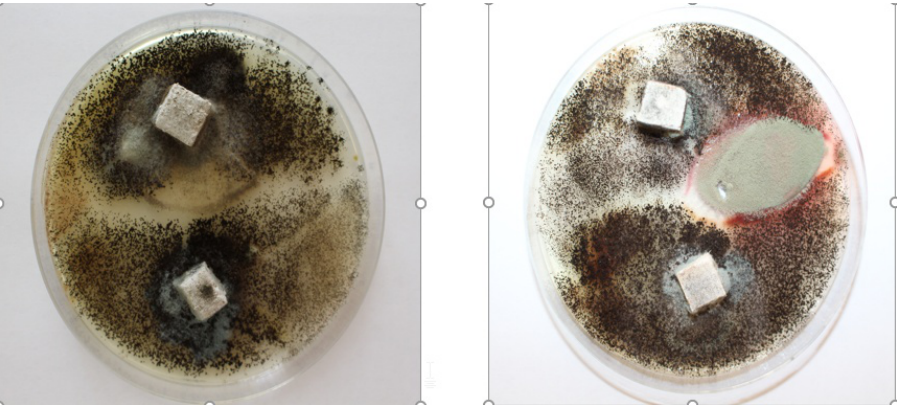
Figure 2. Identification of naturally occurring molds.